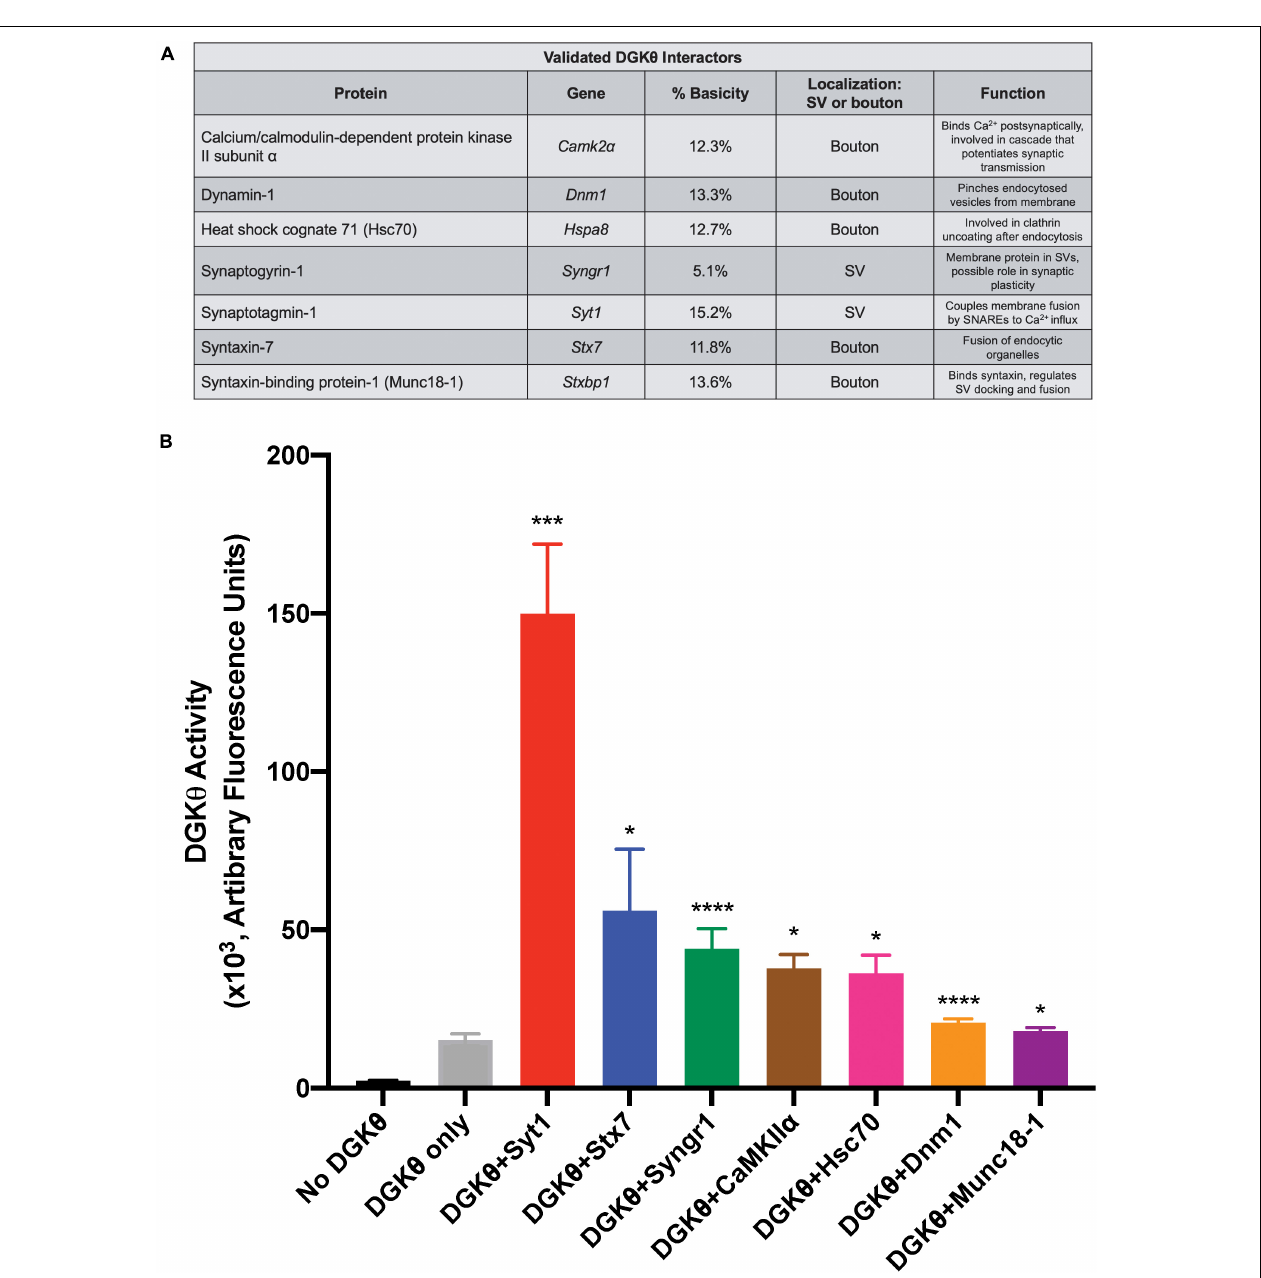
FIGURE 5 | Syt1 increases DGK θ activity 10-fold over DGK θ alone. (A) List of candidate proteins for which an interaction with DGK θ was validated and their function. Syt1 has the highest percent basicity of the confirmed interactors. (B) DGK θ kinase activity was measured for DGK θ alone and for DGK θ (10 ng/ µ L) plus the addition of each confirmed interactor (500 ng/ µ L). Syt1 increased DGK θ activity 10-fold, while syntaxin-7 increased DGK θ activity four-fold. Error bars indicate SEM. Graph summarizes data from 2 experiments with three replicates each, n = 6, * p < 0.05, *** p < 0.0005, **** p < 0.0001 against DGK θ only, ratio paired t